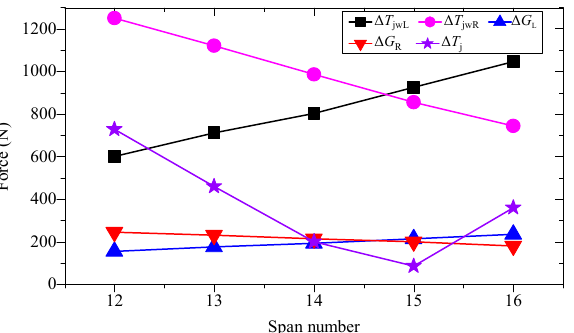
Figure 12. Changes in contact wire tension difference and the downslope component of the trolley wire gravity at different positions of the mid-point anchor.